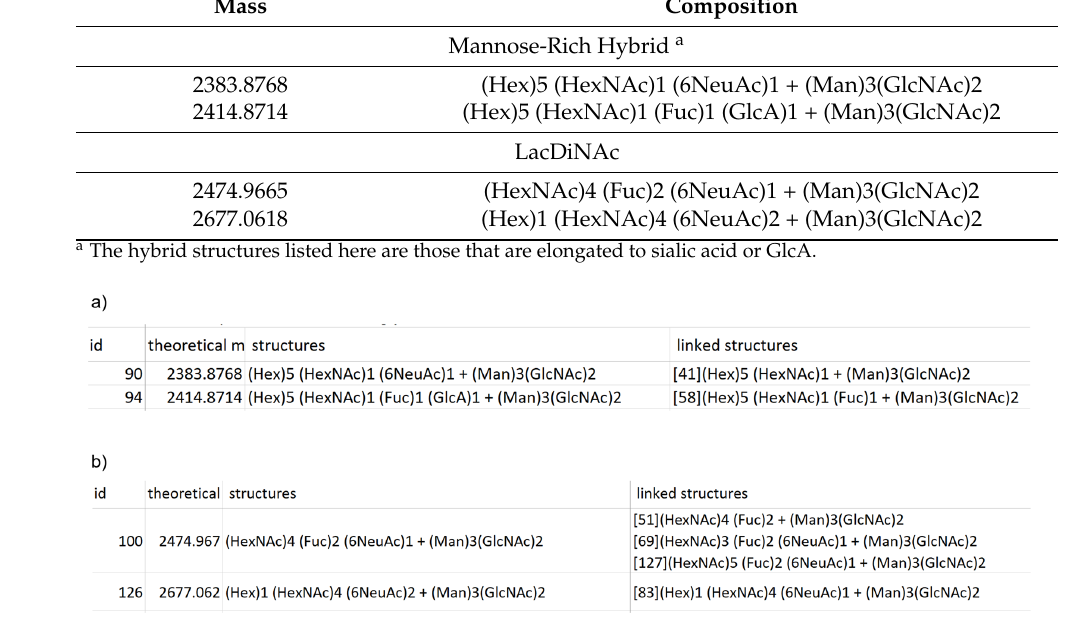
Figure 6. Screenshots of parts with respect to mannose-rich hybrids ( a ) and LacDiNAc ( b ) in the summary file (Table S5). Each column from left to right shows the following: spectral ID, mass, glycan composition, and the plausible glycan composition that differs by only one residue from the glycan composition on the left. Numbers in square brackets are the spectral IDs.